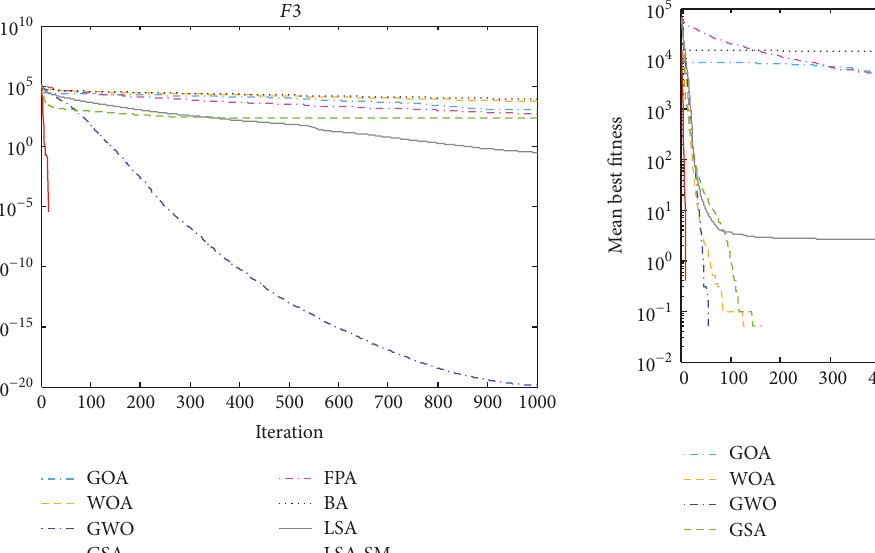
Figure 9: 𝐷 = 30 , convergence curves for 𝑓 05